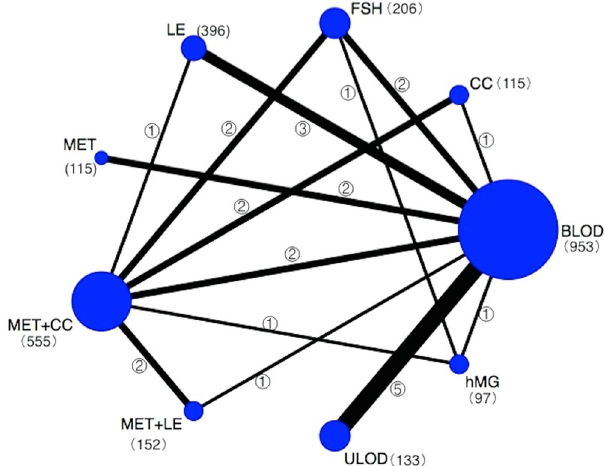
Figure 2. Network plot of the comparisons included in the analysis. CC: clomiphene citrate, MET: metformin, LE: letrozole, FSH: follicle-stimulating hormone, hMG: human menopausal gonadotropin, MET + CC: metformin combined with clomiphene citrate, MET + LE: metformin combined with letrozole, ULOD: unilateral laparoscopic ovarian drilling and BLOD: bilateral laparoscopic ovarian drilling. Numbers next to the treatment indicate participants undergoing a specific therapy; numbers on connecting lines between two comparisons indicate the number of direct comparisons.